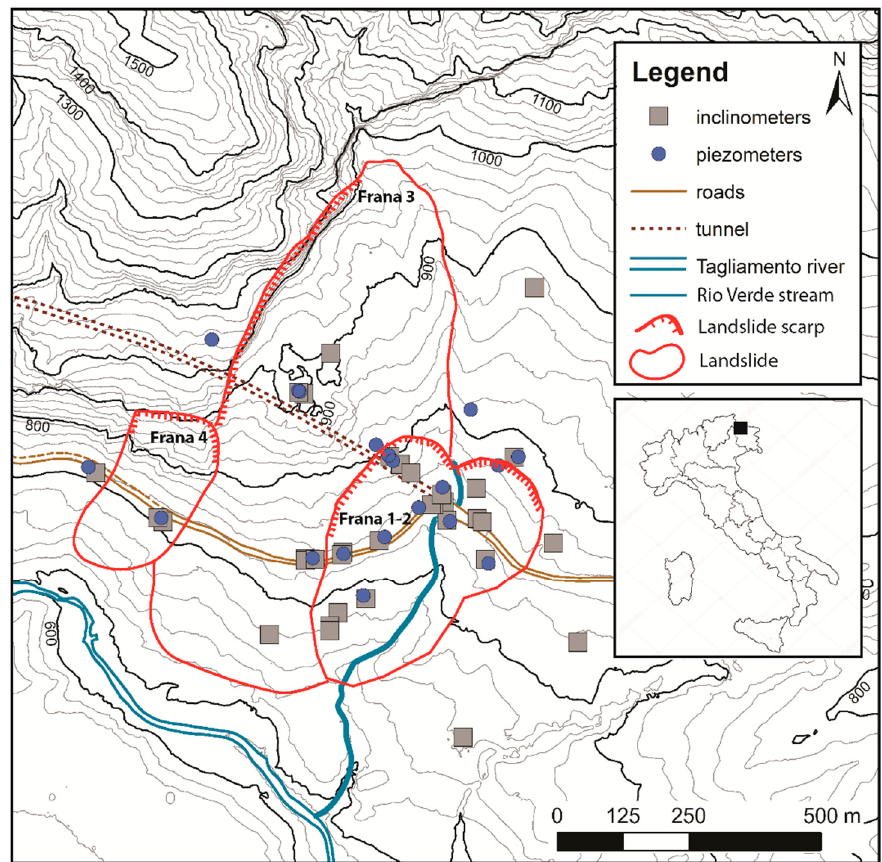
Figure 1. Study area with all the piezometers and inclinometers that have been deployed in the area since 2002 pointed